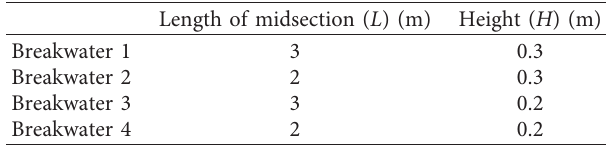
Table 7: Four different breakwater dimensions.